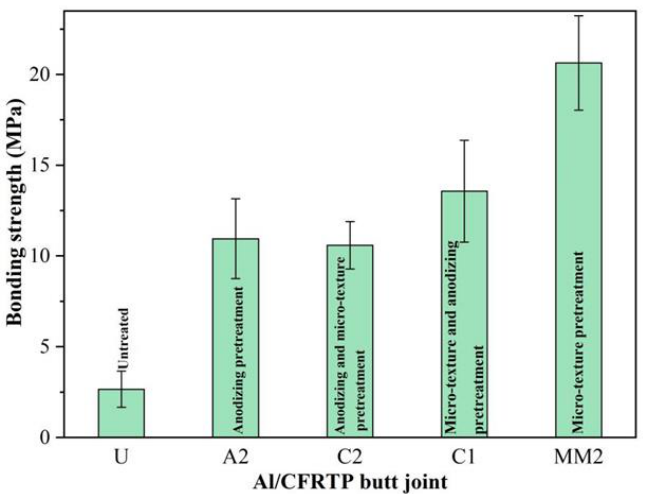
Figure 12. Bonding strength of the Al/CFRTP butt joints with different Al joining interface pretreatments.